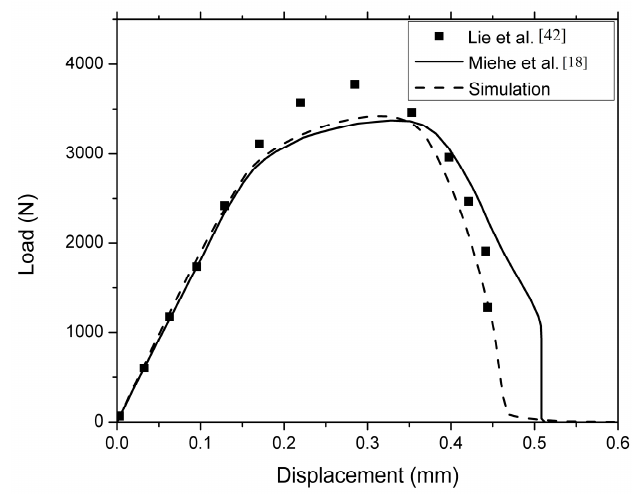
Figure 5. Rate-independent load displacement responses for the V-notched sample in tension.